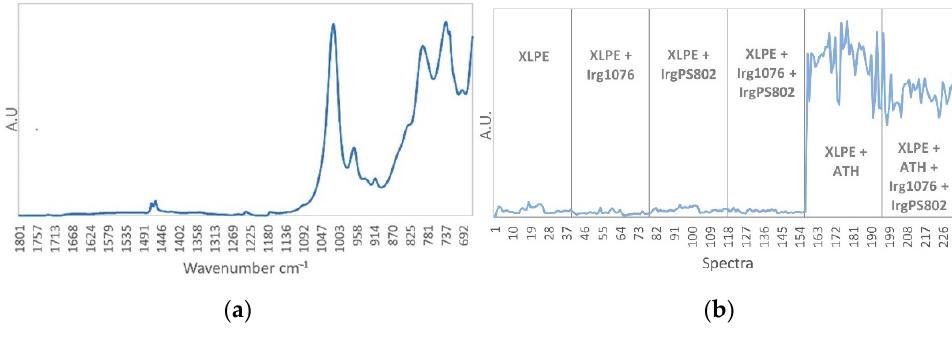
Figure 11. ( a ) ATH pure spectrum. ( b ) ATH concentration profile. The second pure spectrum (Figure 12a) corresponds to Irganox PS802 spectrum, the characteristic infrared band are found at 1733 cm − 1 , 1463 cm − 1 , 1355 cm − 1 1240 cm − 1 , 1180 cm − 1 and 717 cm − 1 according to the identification made in Table 2. The concentration profile (Figure 12b) shows high contributions for the third formulation (XLPE + IrgPS802) between spectra 79 to 90 corresponding to the non-irradiated third film and to the one irradiated at 67 kGy and 40 Gy/h and for spectra 103 to 117 which correspond to the 300 Gy/h irradiation dose rate. For the 40 Gy/h dose rate, from the dose 145 to 374 kGy (spectra 91 to 102) the contribution decreases with the dose and point out the Irganox PS802 consumption. For the fourth formulation (XLPE + Irg1076 + IrgPS802) high contributions are founded for spectra 118 to 126, and 142 to 156 which correspond respectively to non-irradiated sample and irradiated samples at 300 Gy/h dose rate. For the 40 Gy/h dose rate, from the dose 145 to 374 kGy (spectra 130 to 141) the contribution decreases with the dose and point out the Irganox PS802 consumption as observed for the previous sample. For the last formulation (XLPE + ATH + Irg1076 + IrgPS802) the concentration profile shows high contributions of Irganox PS802. This contribution is extremely noisy which shows a poor distribution of the additives in the sample. As previously, the Irganox PS802 consumption seems to be observed for the samples irradiated at 40 Gy/h dose rate, from the dose 145 to 374 kGy (spectra 208 to 219) with the decrease of the contribution with the dose.